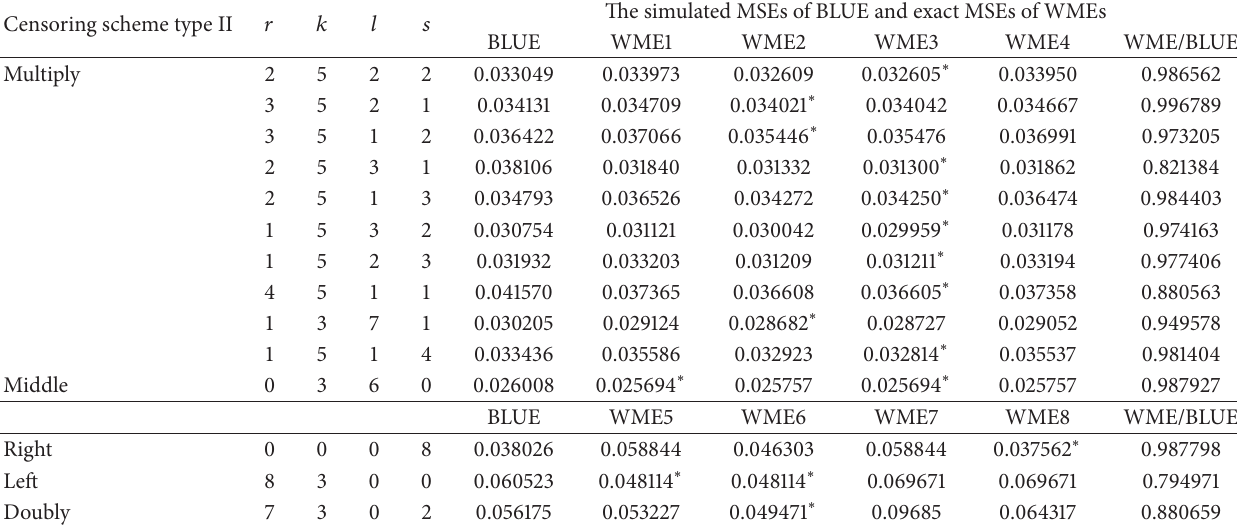
Table 2: MSEs of BLUE and WMEs of the scale parameter 𝜎 at 𝑁 = 25 , 𝜎 = 1.0 , and 𝜃 = 1